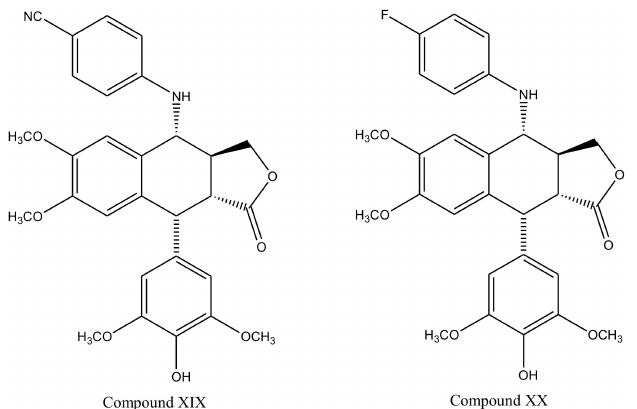
Figure 3. Podophyllotoxin derivatives produced by selective cleavage of ring A through Schreier’s method and the modified-Schreier method. These ring-A-open compounds, however, appeared biologically less active than podophyllotoxin